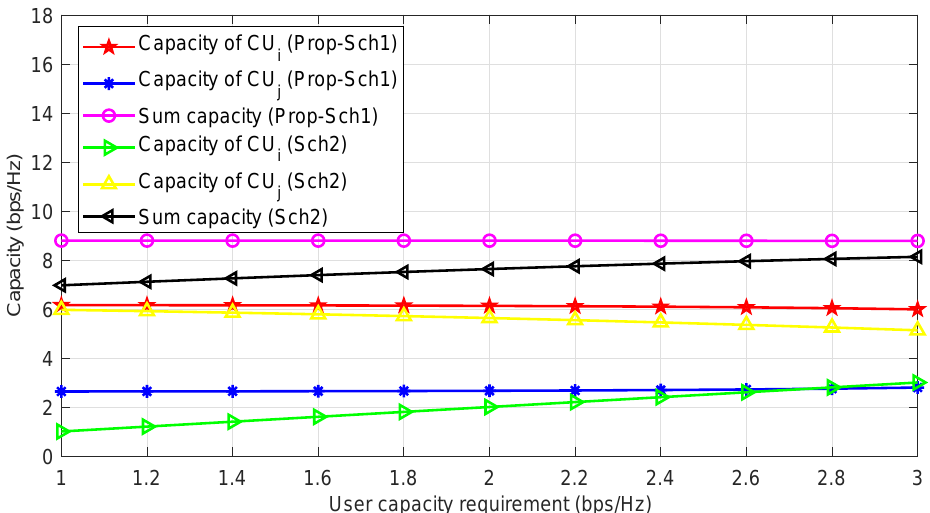
Figure 4. Capacity of Prop-Sch1 and Sch2 versus user minimum capacity requirement when P BS = 20.